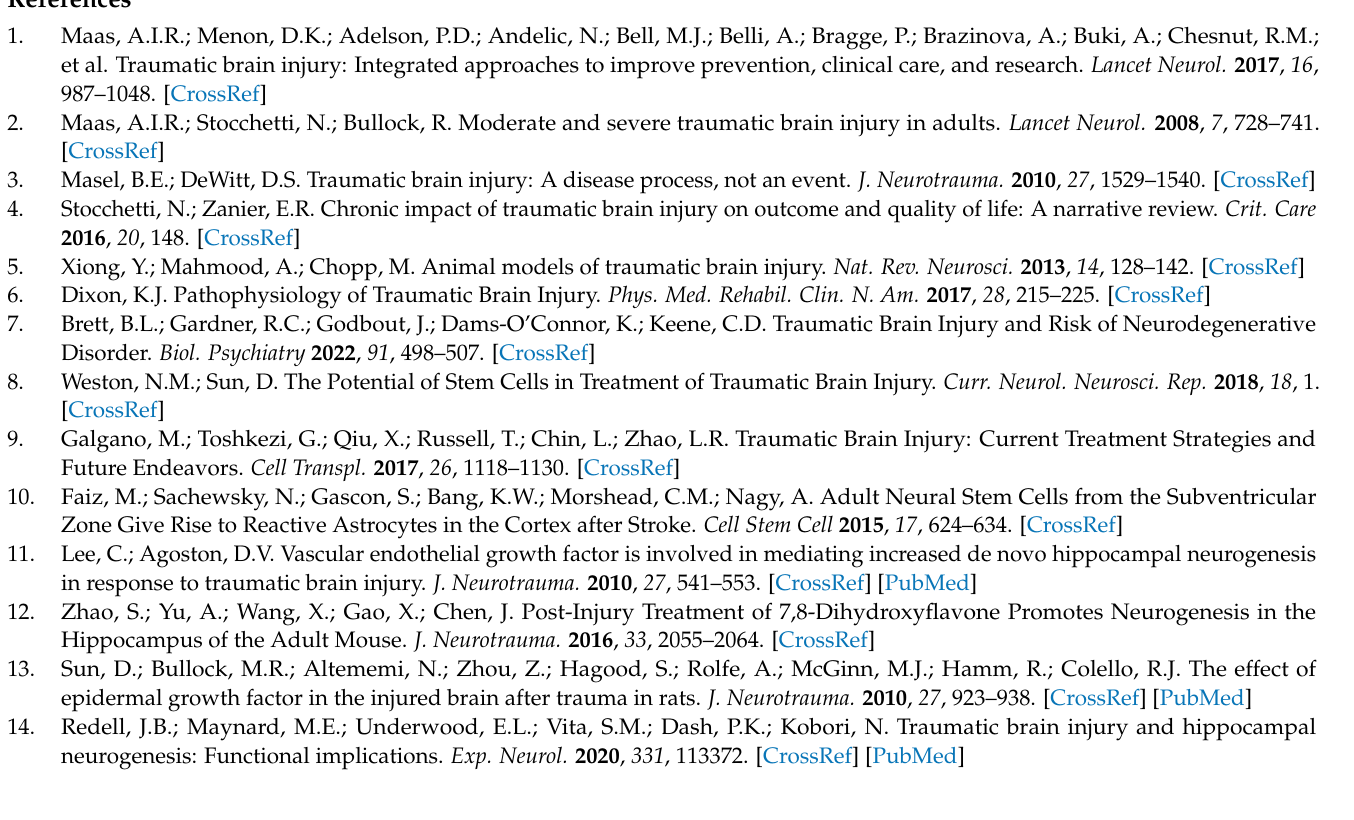
knockout of Tgm2 in hippocampal NSPCs. Figure S2: TGM2 is required for hippocampal neurogenesis. Figure S3: TGM2 promotes self-renewal and migration of NSPCs. Figure S4: Tgm2 -deletion resulted in transcriptional changes in NSPCs. Figure S5: Deletion of Tgm2 dysregulates the expression of genes associated with NSPCs proliferation and